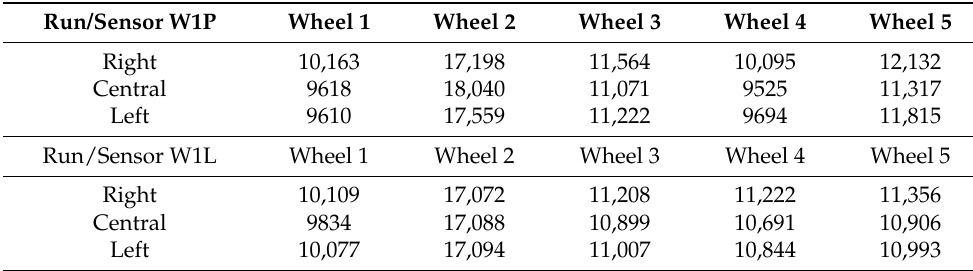
Figure 15. Example of signals from the first line of strain gauges for right- and left-side run and central—five-axle vehicle. Table 4. Strain gauge sensor signal characteristics—signal amplitude in Analog-Digital Unit (ADU).